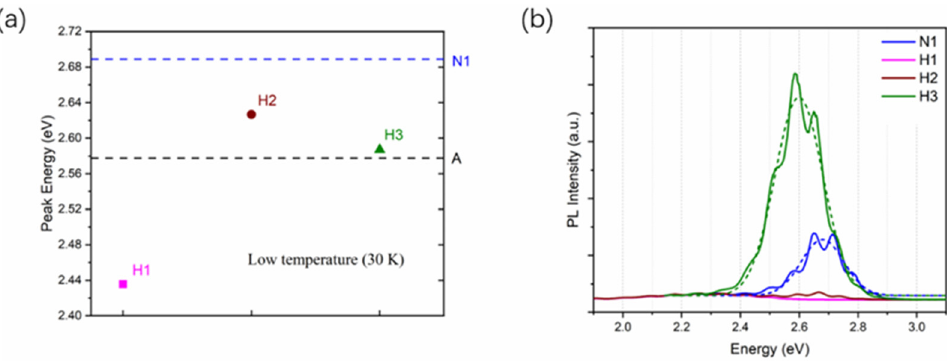
Figure 6. ( a ) PL peak energy distribution of samples treated with hydrogen at 30 K. The dashed lines indicate the peak energy position of sample A and N1 as a reference; ( b ) PL spectra of samples measured at room temperature for samples N1 (blue), H1 (pink), H2 (brown), and H3 (green). The dashed lines show the Gaussian fitting curves of sample H3 and sample N1.